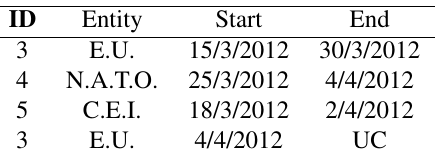
Table 3. Sample historical